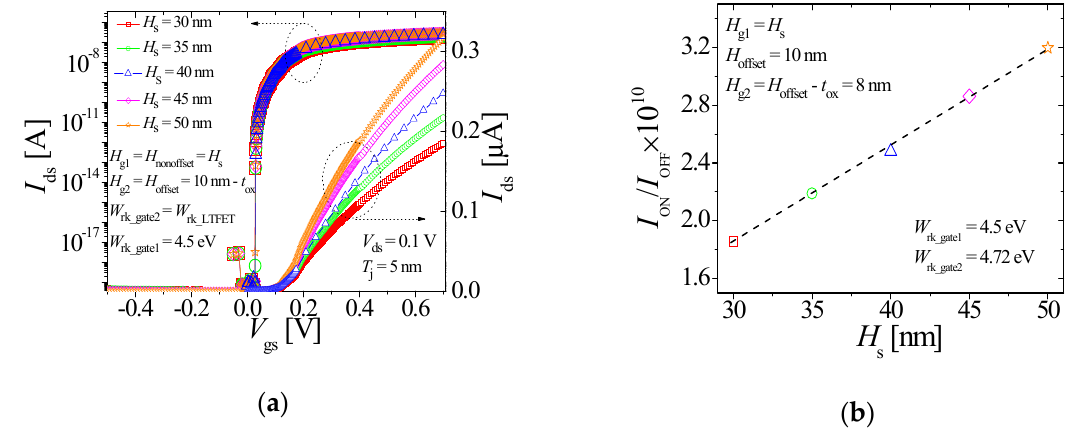
Figure 10. I ds - V gs characteristics of DG-LTFET with different H s , fixed W rk_gate1 = 4.5 eV, W rk_gate2 = W rk_LTFET , and H g1 = H s = H nonoffset , H g2 = H offset (=10 nm) − t ox = 8 nm. ( b ) An I ON / I OFF ratio of I ds - V gs characteristics shown in ( a ). Red squares, green circles, blue triangles, magenta diamonds, and orange stars: H s = 30, 35, 40, 45, and 50 nm, respectively.